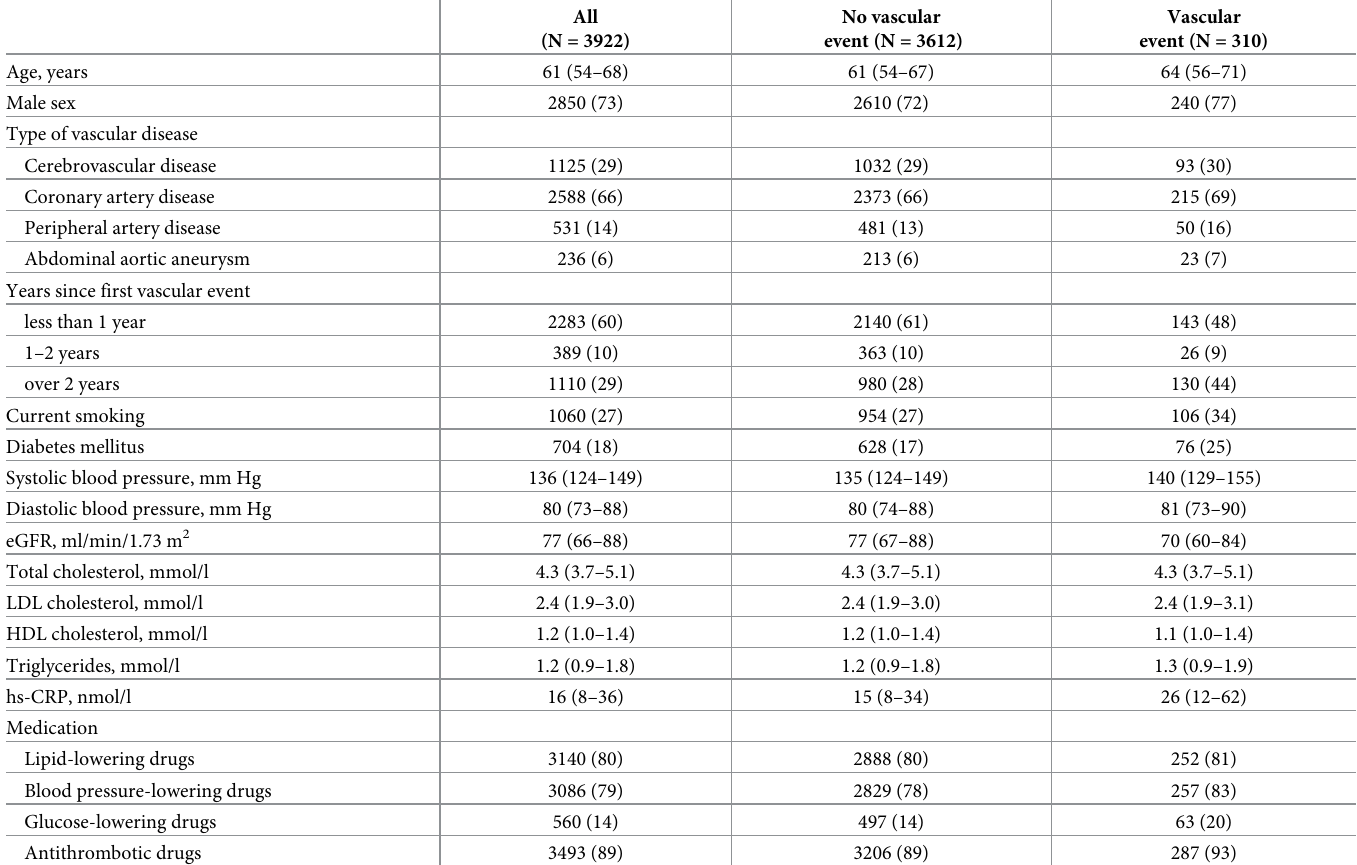
Table 1. Baseline